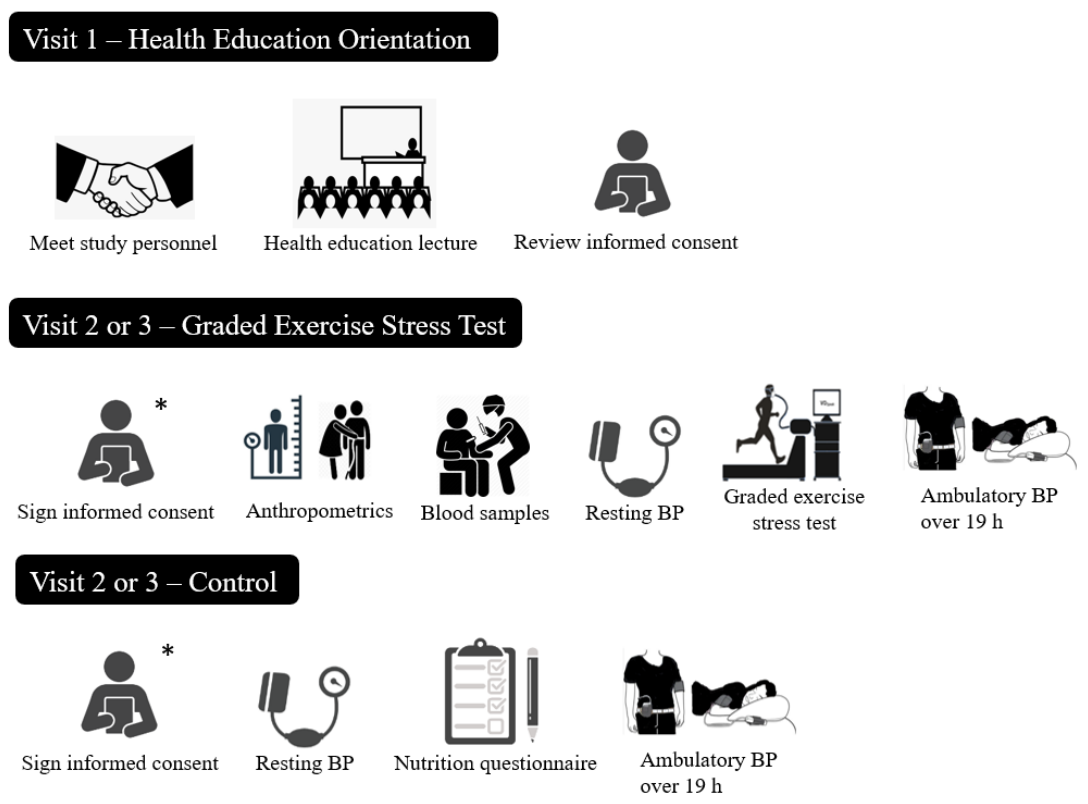
Figure 1. Study Design Overview. Note: BP = Blood pressure. * Subjects signed the informed consent during their Visit 2.